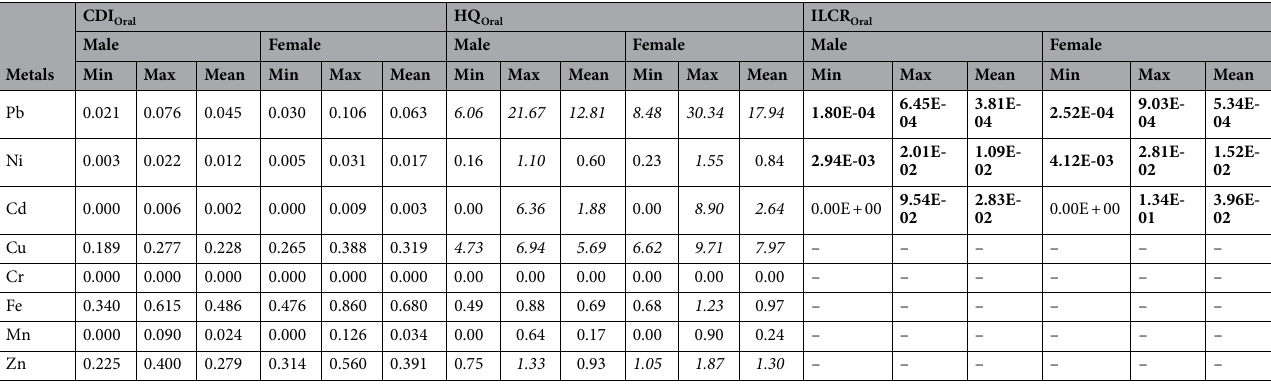
Table 7. Calculated chronic daily intake (CDI), hazard quotients (HQ) and incremental lifetime cancer risk (ILCR) values for male and female due to oral exposure of trace metals from the dietary intake of brinjal fruits collected from different producer levels. Italic HQ Oral values indicate non-cancer risk and bold ILCR Oral values indicate the cancer